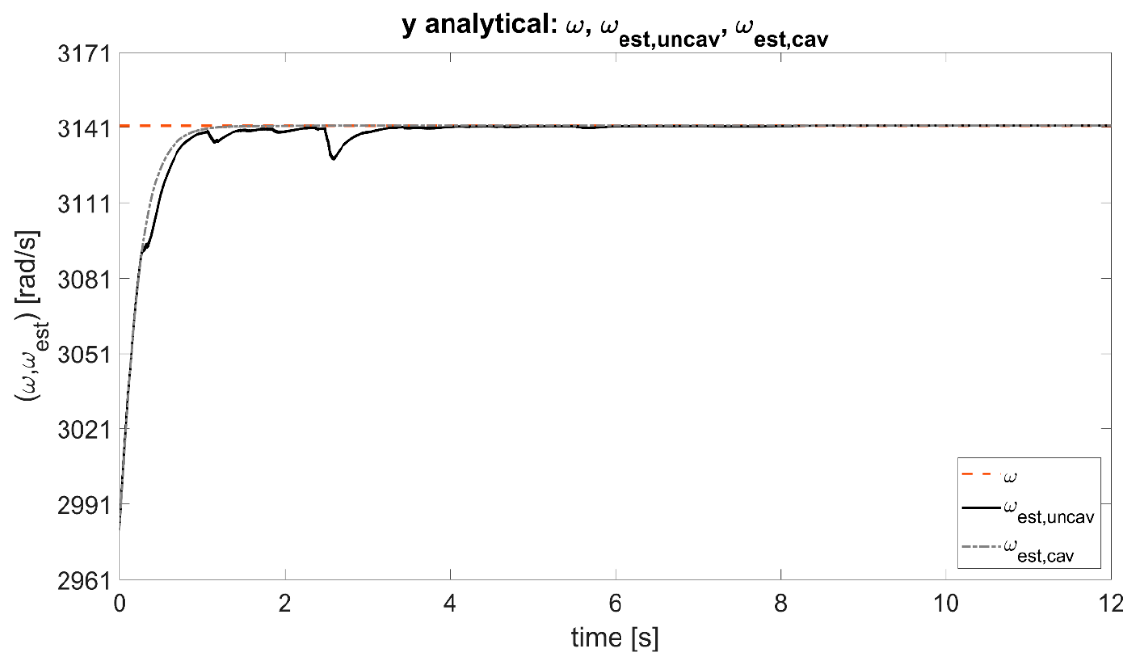
Figure 6. Comparison of frequency estimation performance in uncavitated and cavitated conditions with the analytical output noise y an